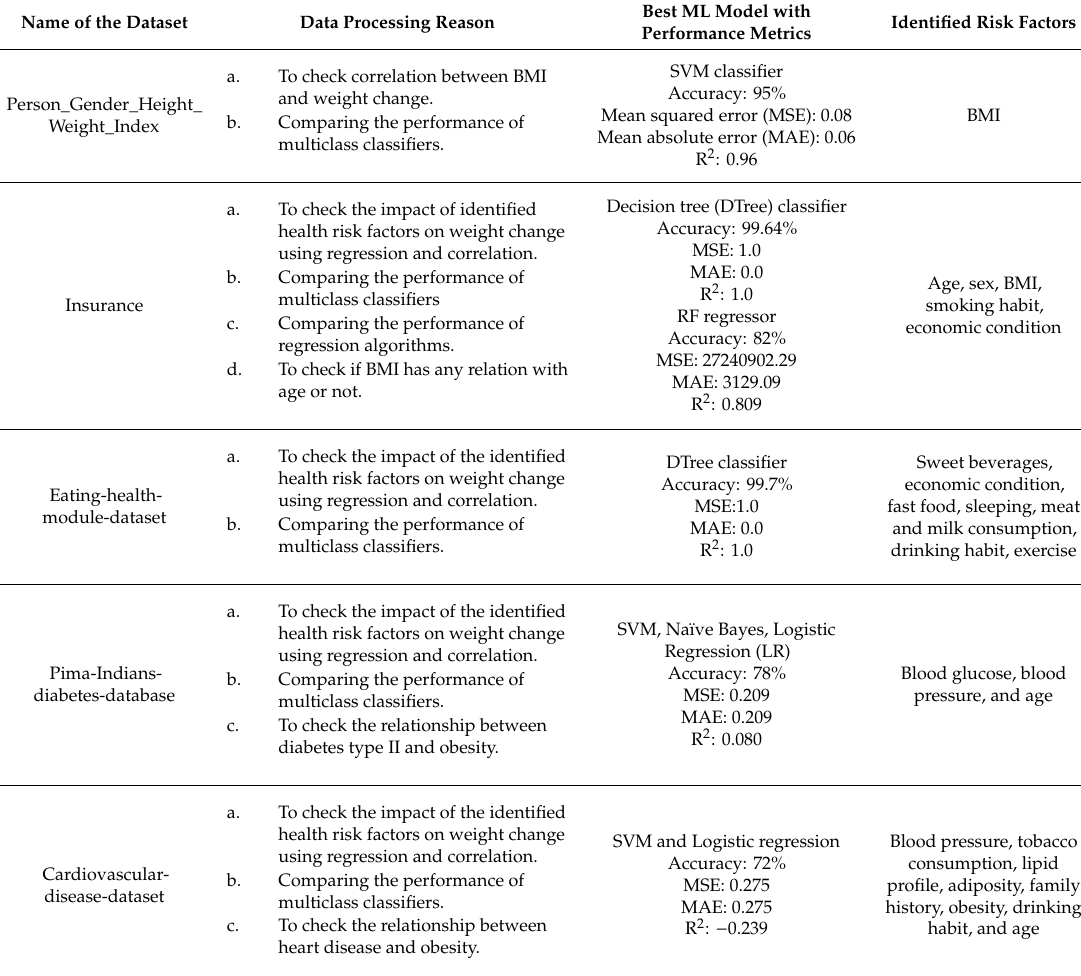
Table 11. The data processing synopsis with a discrimination analysis.